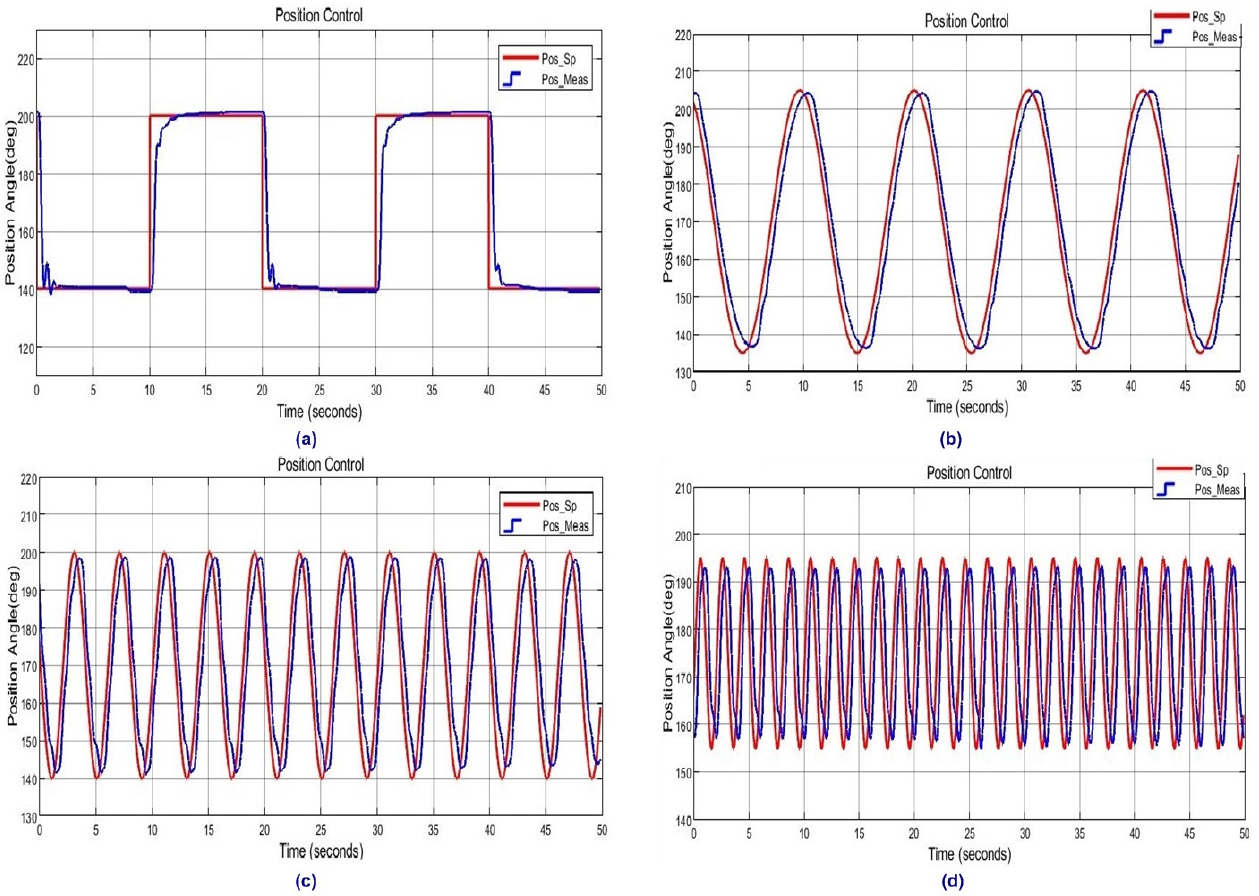
Figure 16. Position trajectory responses when NARX estimation-based control is active: ( a ) step reference, ( b ) 0.1 Hz sinusoidal reference, ( c ) 0.25 Hz sinusoidal reference, and ( d ) 0.50 Hz sinusoidal reference.